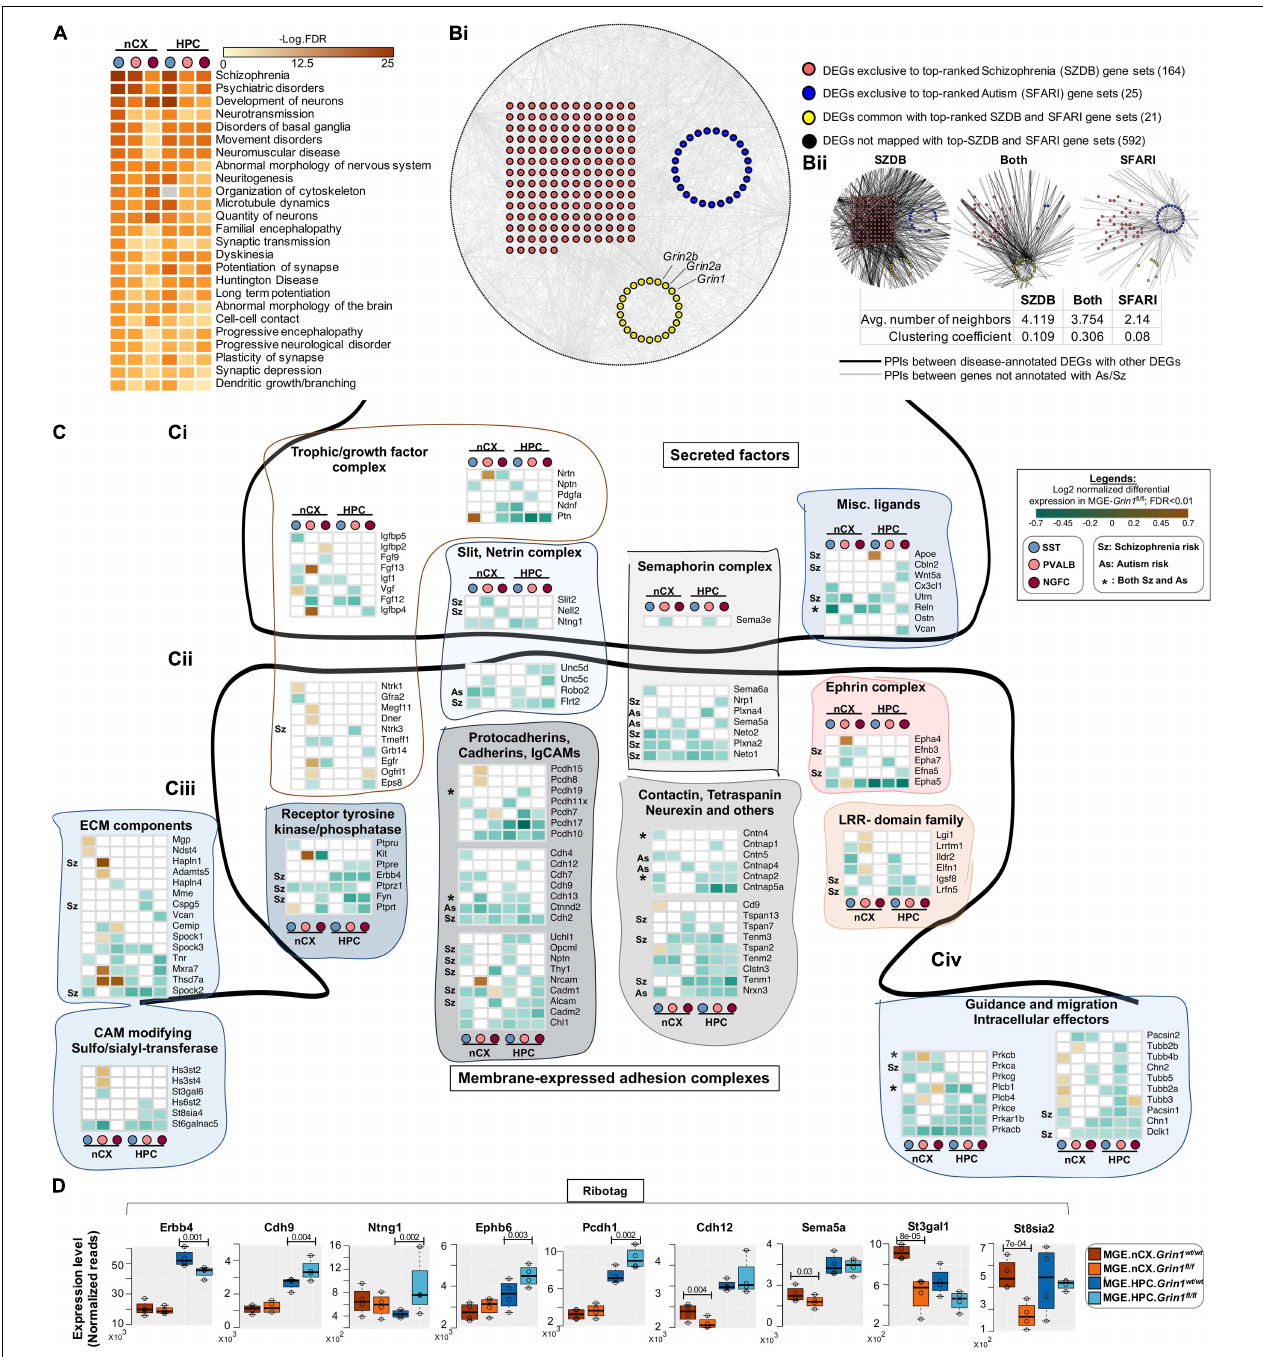
FIGURE 8 | Aberrant NMDAR signaling results in misexpression of high-risk Sz genes. (A) Ingenuity Pathway Analysis of significantly overrepresented disease pathways in each MGE-subtype. FDR determined by Fisher’s Exact Test. (Bi) Global protein-protein interaction (PPI) map among all differentially expressed genes (DEGs). Red circles indicate the DEGs annotated to be top-ranked Sz-risk genes; Blue circles indicate the DEGs annotated to be top-ranked As-risk genes; Yellow circles indicate the DEGs annotated with both Sz and As-risk genes. Black circles in the periphery indicate the DEGs not annotated with high-risk Sz/As genes. The PPIs between DEGs indicated in gray lines. (Bii) PPIs between Sz/As/dually enriched clusters, and other genes. The PPIs between disease-annotated DEGs and other disease-annotated DEGs or with other non-annotated DEGs are indicated in black lines. The PPI between non-annotated DEGs indicated in gray lines. (C) Heatmap of log2 FC of significant DEGs in cortical and hippocampal MGE cardinal subtypes, showing a subset of (Ci) , secreted trophic factors and secreted ligands and guidance cues. (Cii) Membrane-bound synaptogenic receptors and cell adhesion molecules (CAMs) (Ciii) , extracellular Matrix (ECM) components and matrix modifying enzymes. (Civ) Intracellular effectors of guidance and synaptogenic cues. (D) MGE-Ribotag-seq normalized reads, cross-validating the differentially expressed synaptic partnering molecules.